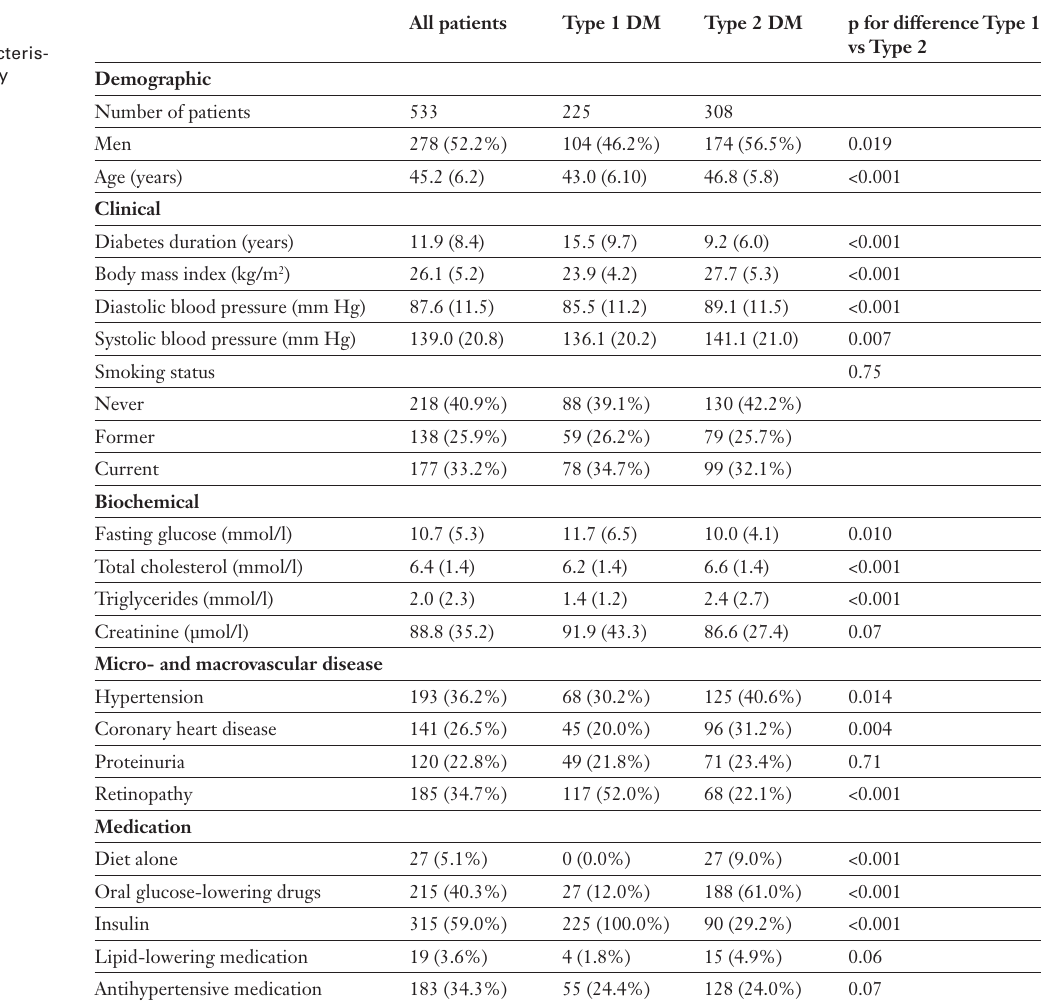
Table 1 Baseline characteris- tics of the study